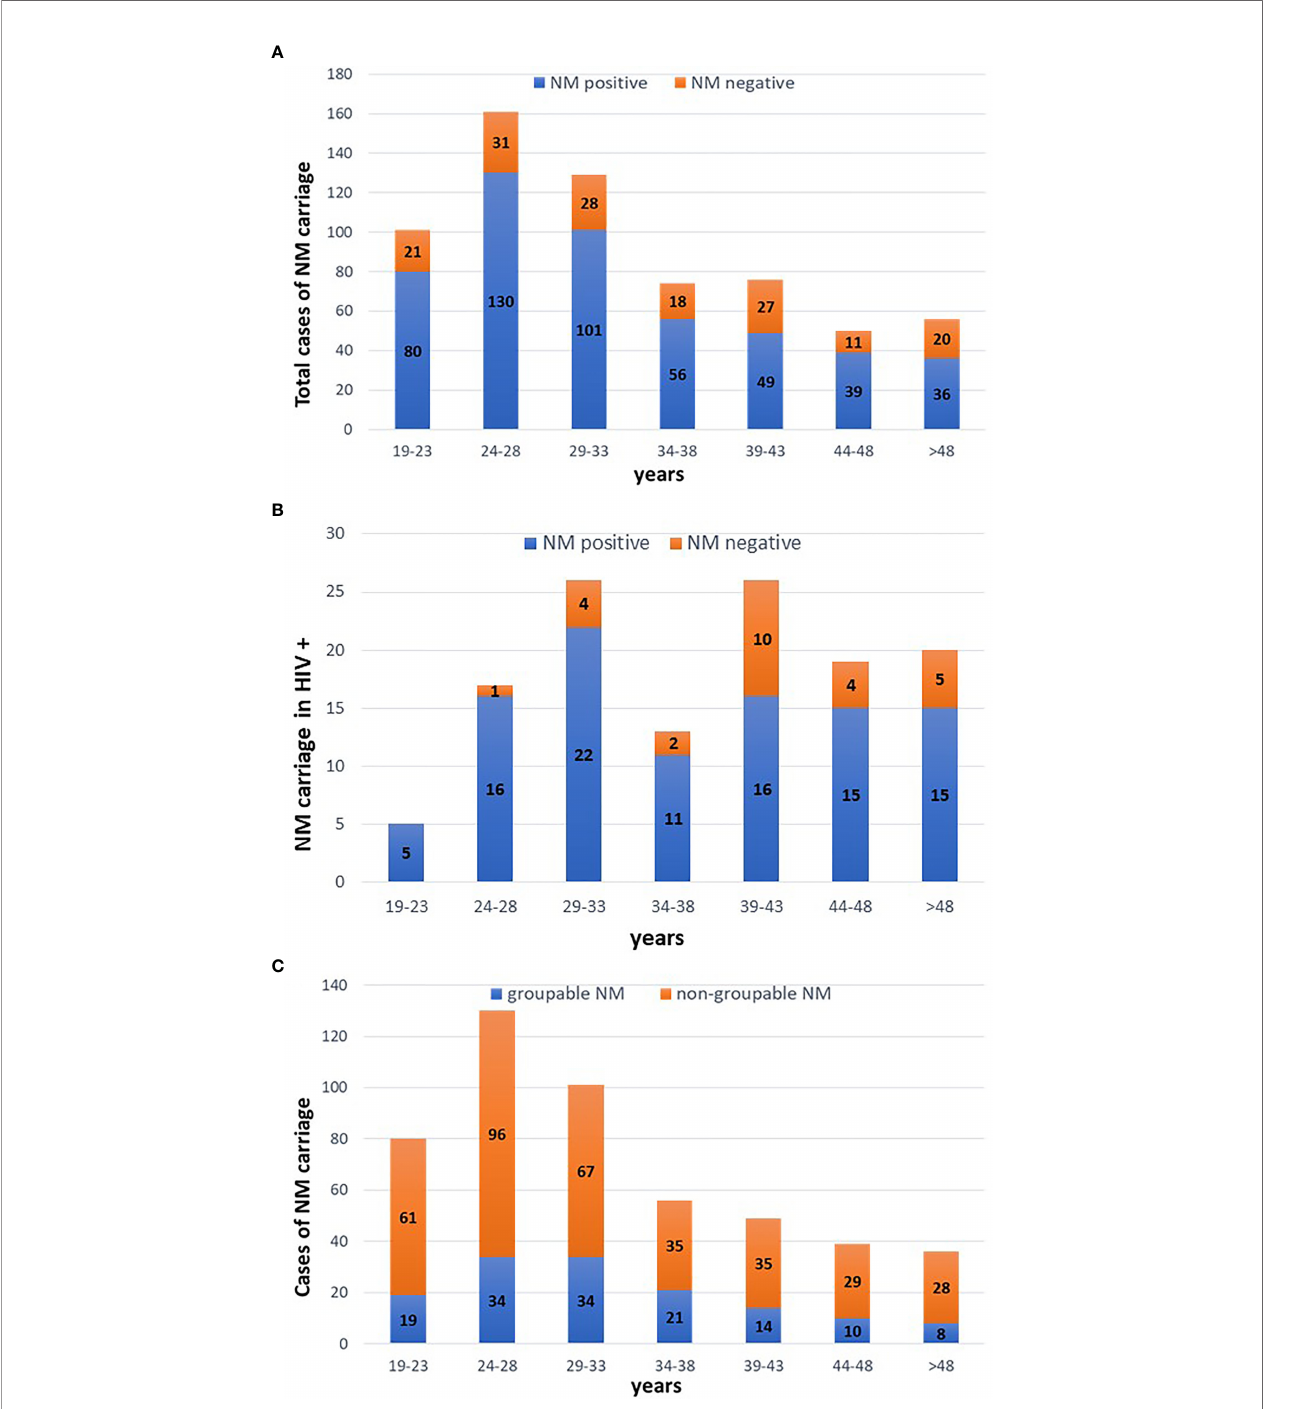
FIGURE 1 | Cases of meningococcal carriage strati fi ed by age. Five-years periods were considered. (A) distribution of NM positive and negative cases considering all the MSM included in the study. (B) distribution of NM positive and negative cases in HIV positive people. (C) distribution of groupable and non- groupable NM